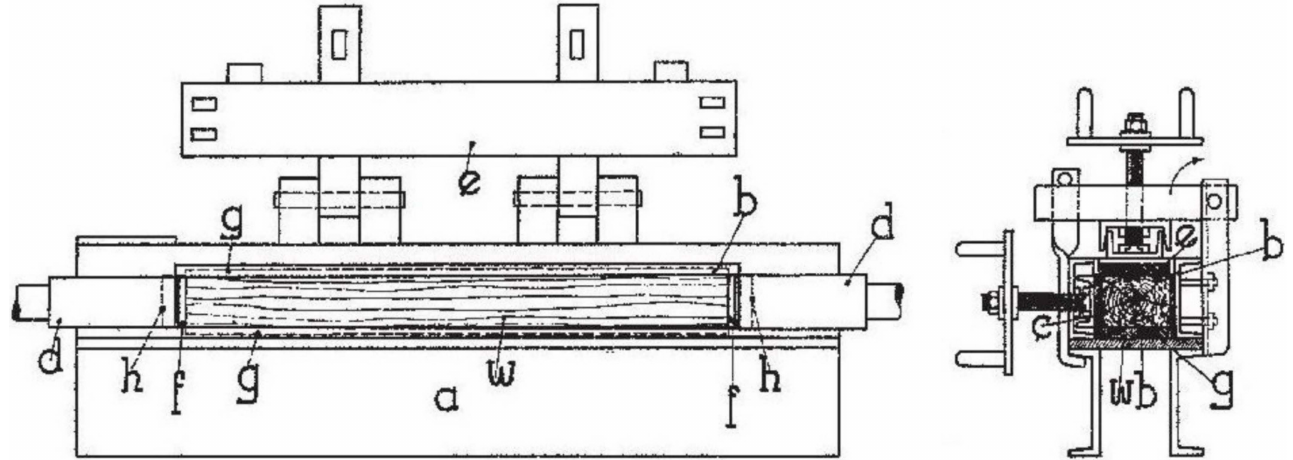
Figure 2. Longitudinal and cross-sections of the first compressing machine. Reproduced from [49]. Abbreviations: a—stand; b—groove; c—openable side wall; d—press plate; e—openable side wall; f—mobile end wall; g—mounting stem; h—groove; w—workpiece.